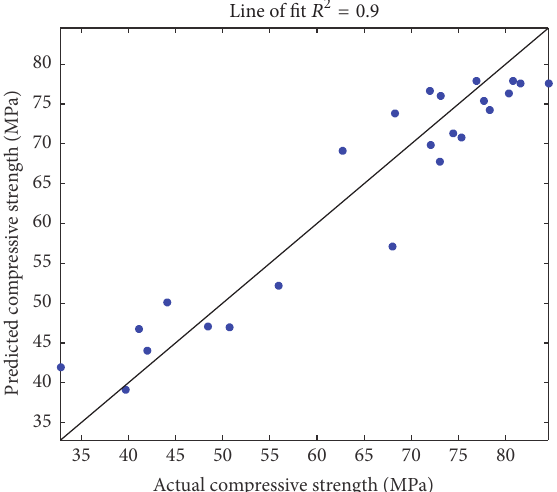
Figure 1: GPR prediction result in the testing phase.